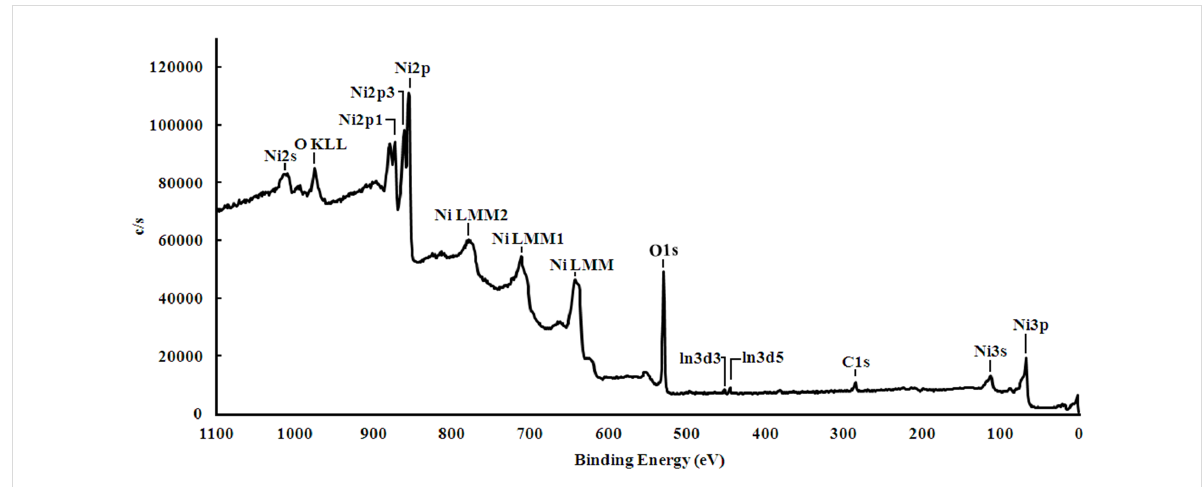
Figure 8: Collected XPS spectrum of NiO nanopowders synthesized using the cryochemical method.